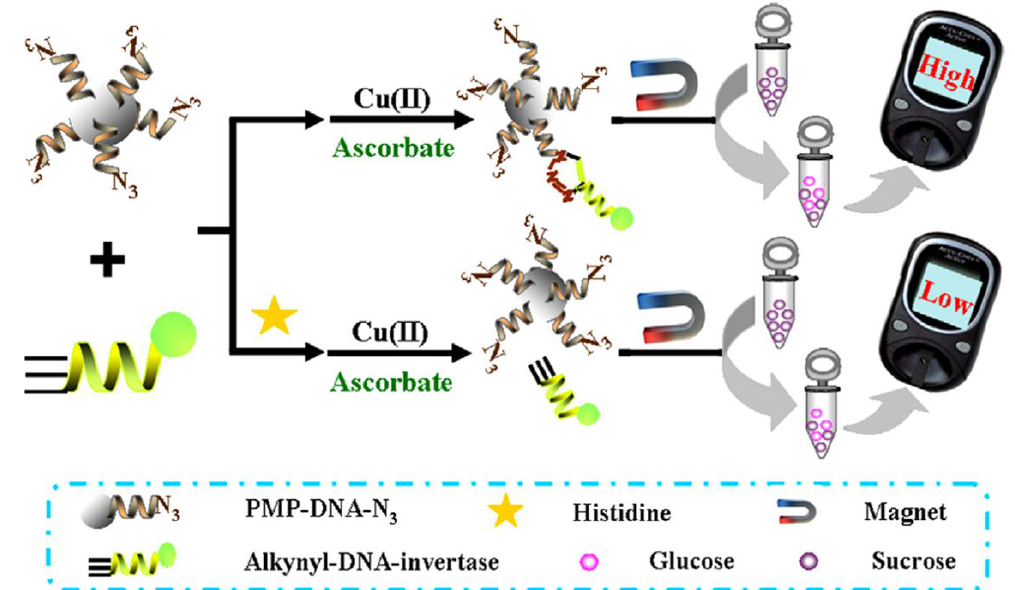
Figure 11. Schematic display of the portable chemical sensor for the determination of histidine, making use of click chemistry and PGM. Reproduced from [81] with